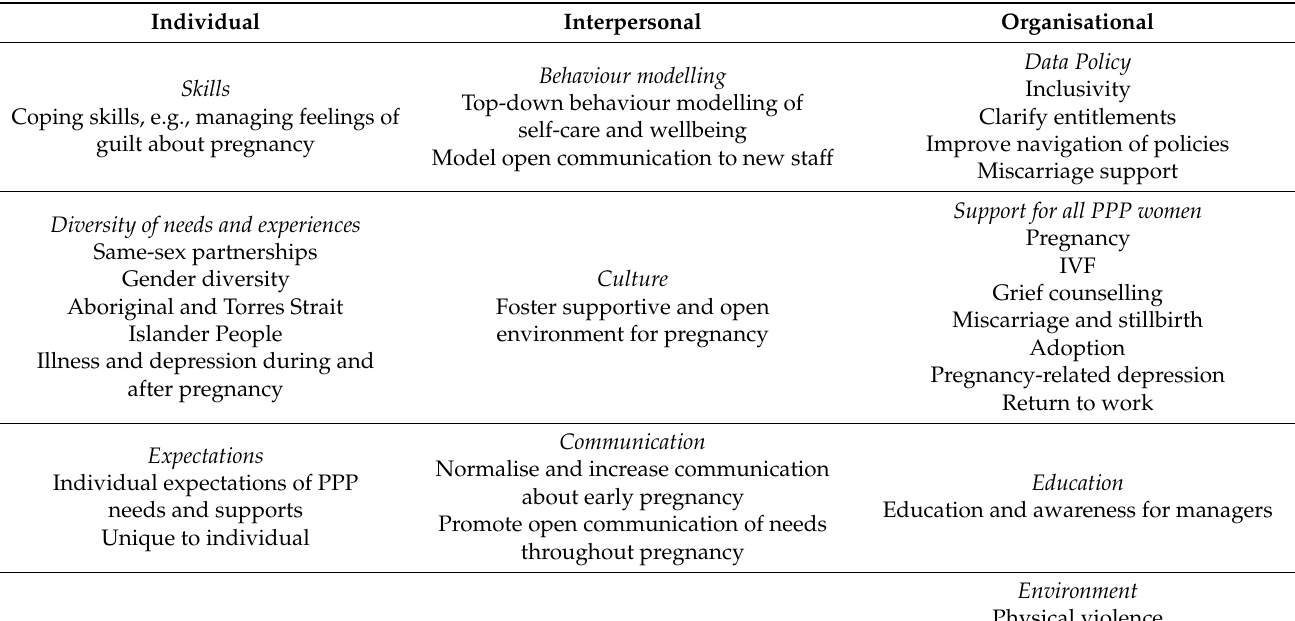
Table 4. Prioritising the needs from the needs